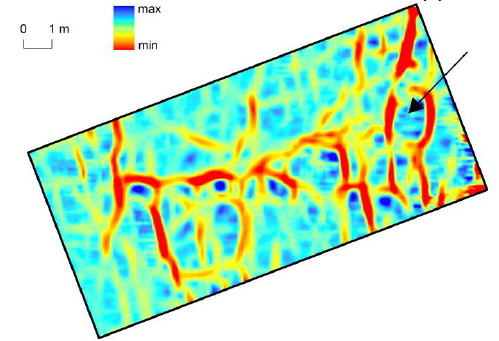
Figure 6. C min map obtained with a moving window of 7x7 cells. Red colour (minimum values of C min ) indicates the concavities. The black arrow indicates the likely unstable rock shown in Figure 3